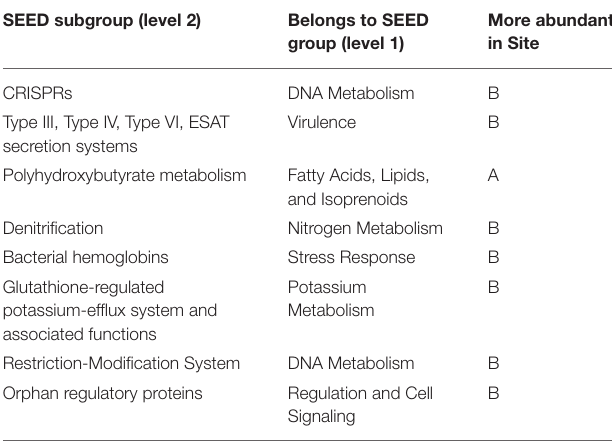
TABLE 5 | SEED subgroups that differed in abundance between Sites A and